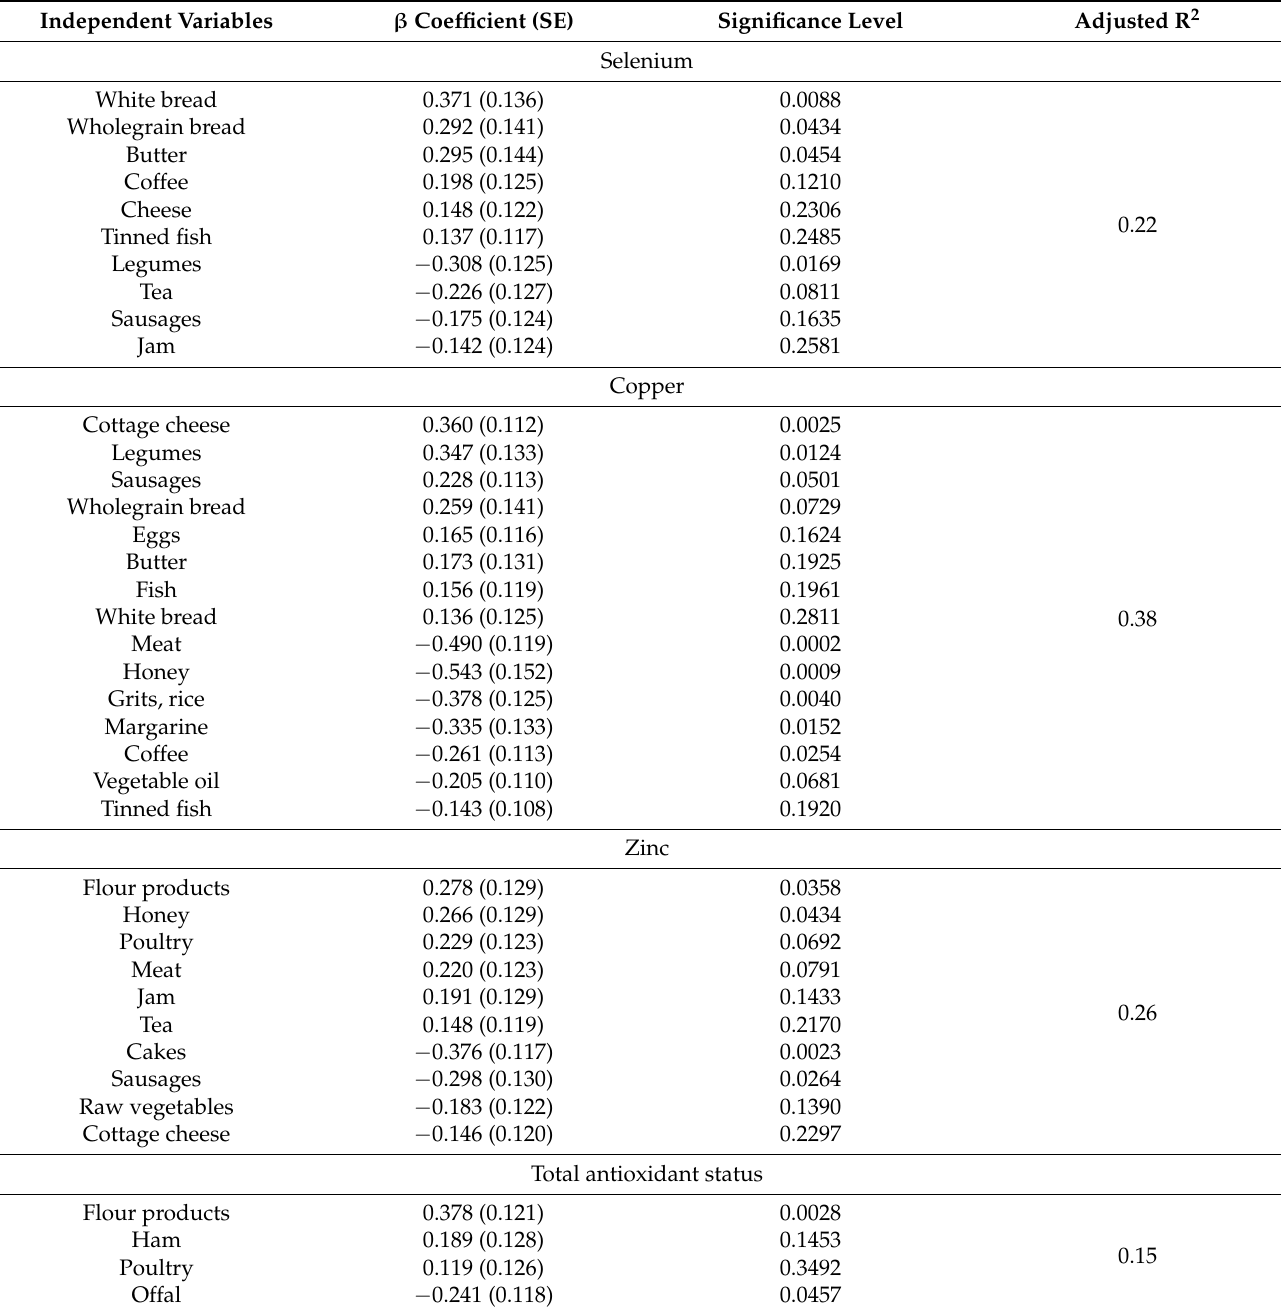
Table 3. Stepwise multiple linear regression analysis of the influence of the frequency of consuming food products on the content of Se, Cu, Zn, and TAS in the serum of patients with AD: β coefficients and significance of variables entered in the model